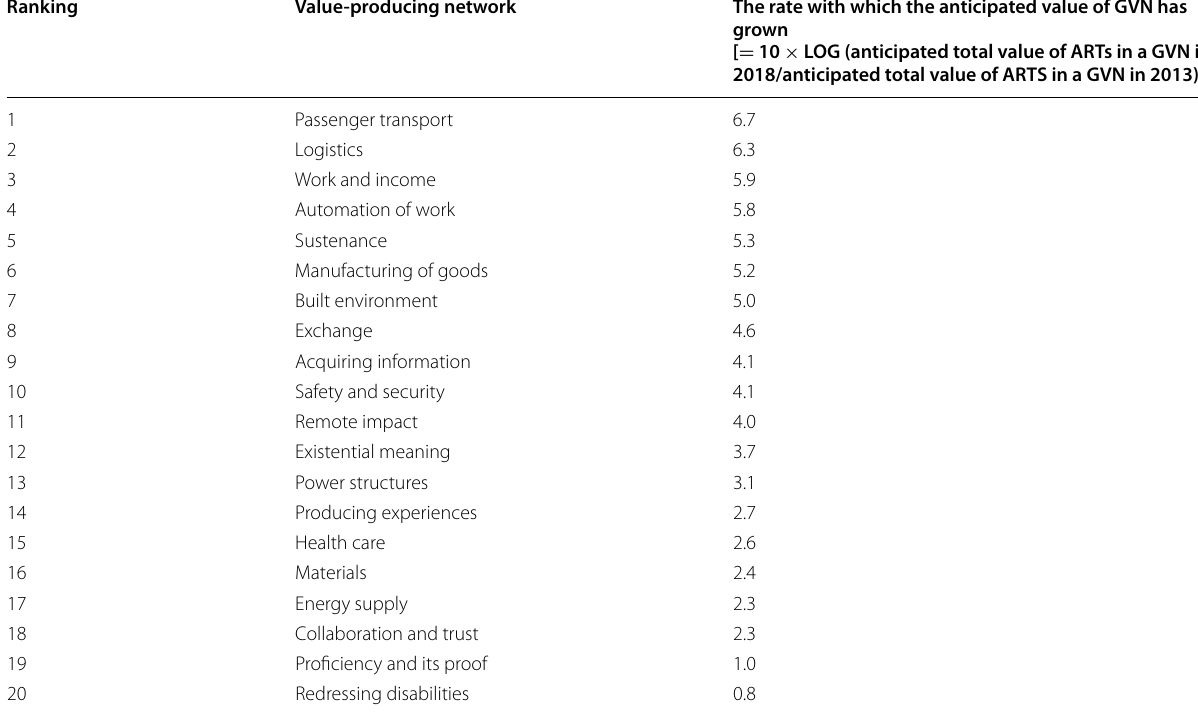
Table 5 Global value-producing networks (GVNs) are arranged according to the rate of anticipated development speed Ranking Value-producing network The rate with which the anticipated value of GVN has